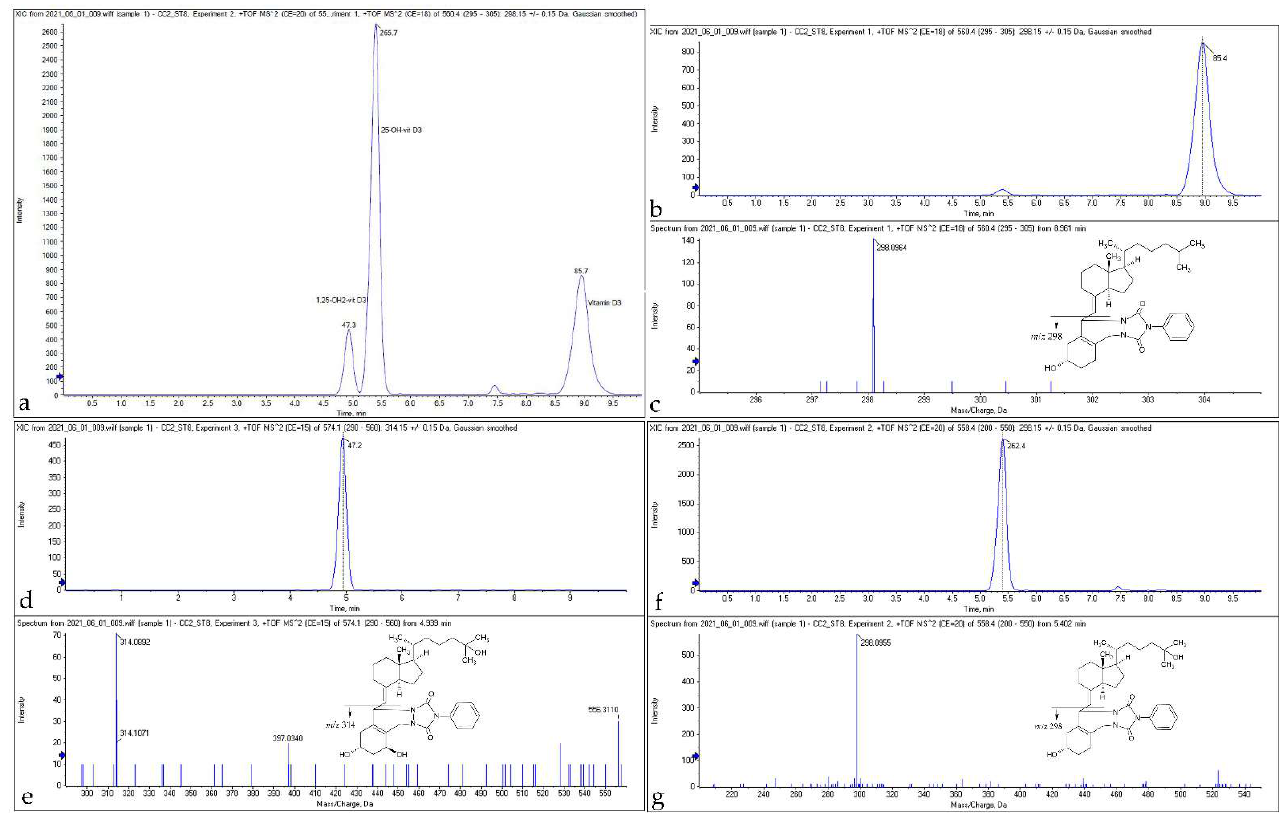
Figure 1. Representative merged chromatograms ( a ) and mass spectra of serum samples spiked with standard solutions of vitamin D3 ( b , c ), 25(OH)D3 ( f , g ), and 1,25(OH)2D3 ( d , e ), containing 50 ng/mL analyte extracted by liquid-liquid extraction using a mixture of methyl-tert-buthyl ether and hexane (1:1) and analyzed with UHPLC-ESI-MS/MS after derivatization with PTAD.